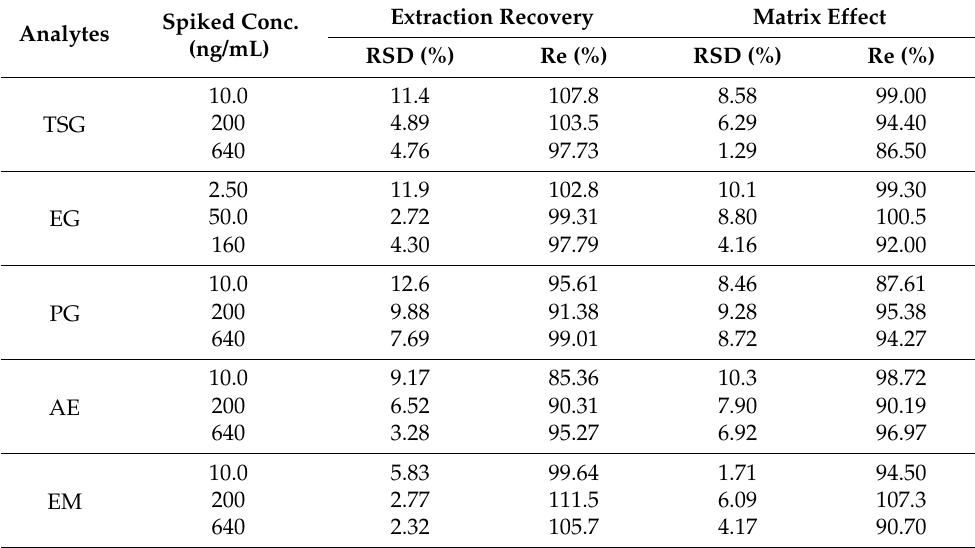
Table 3. Recovery and matrix effect of TSG, EG, PG, AE, and EM ( n = 6).